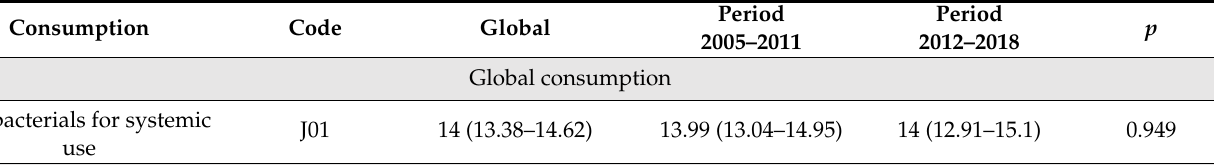
Table 1. Consumption (DID) of total and most commonly used antibiotics and pattern of use in pediatric outpatients in Asturias. Global data and comparison between periods.